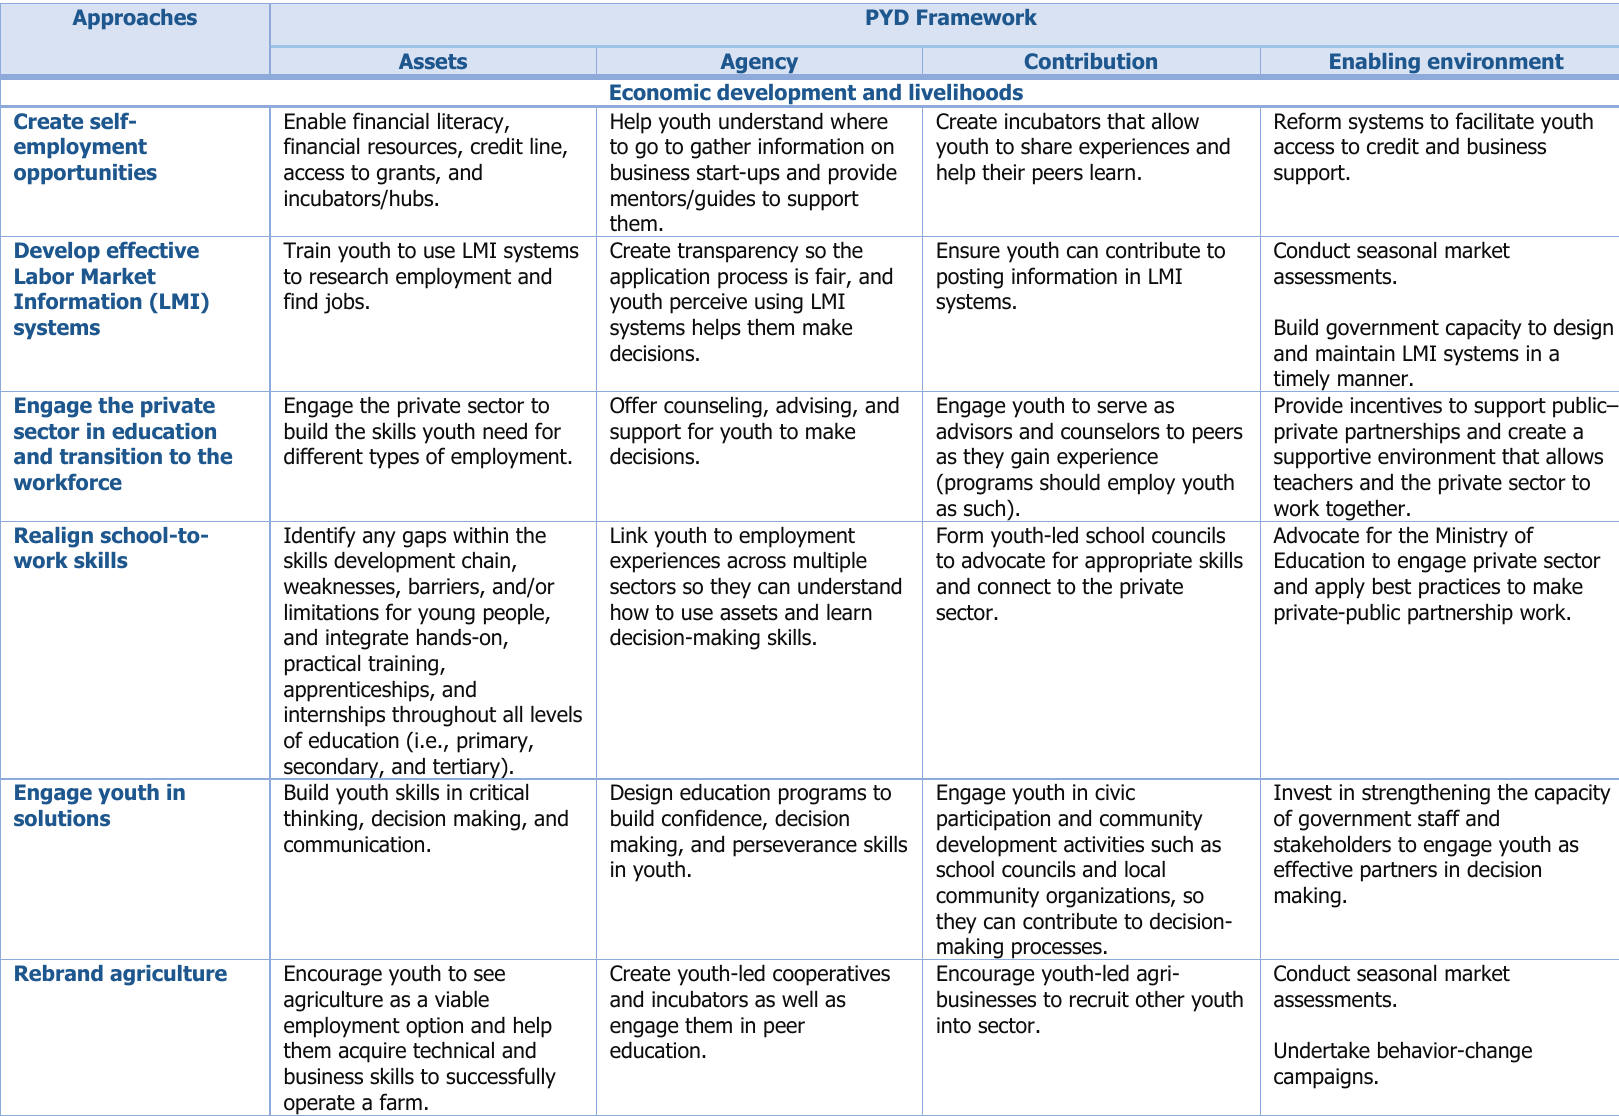
Table 13. Programming Approaches Addressing Sector-Specific Findings Using a PYD